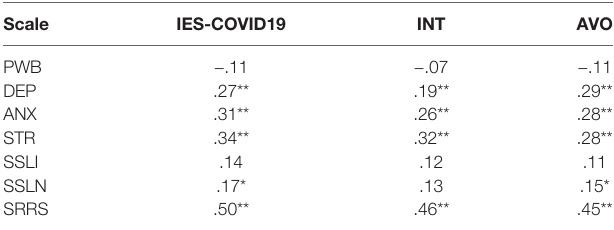
TABLE 4 | Pearson ’ s Correlations Between the Total IES-COVID19, Subscales, and Other Scales.